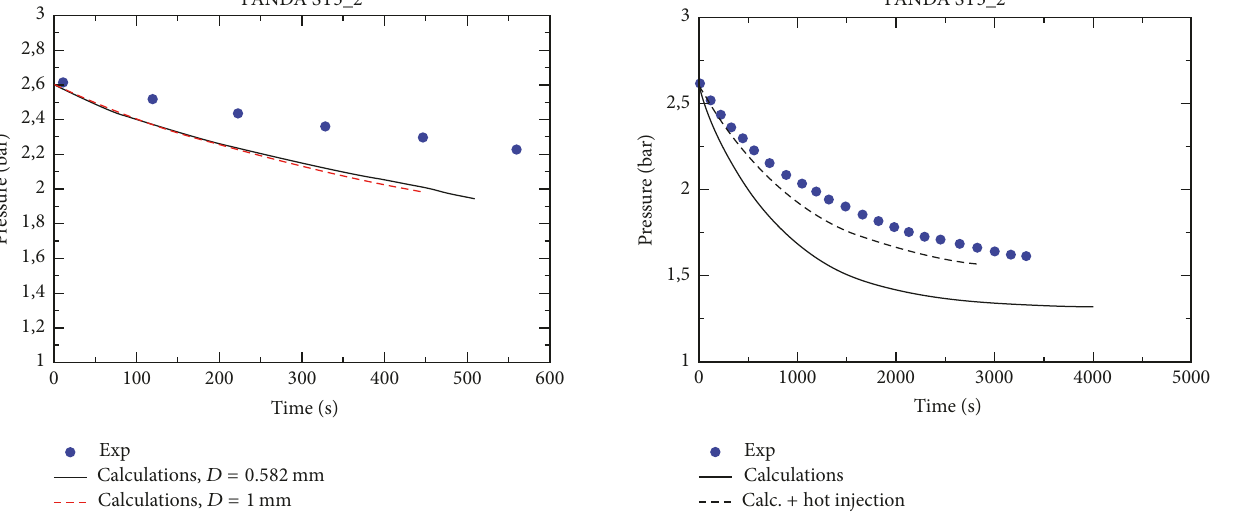
Figure 28: Time-dependent pressure in Vessel-1, sensitivity to the gas temperature at injection.